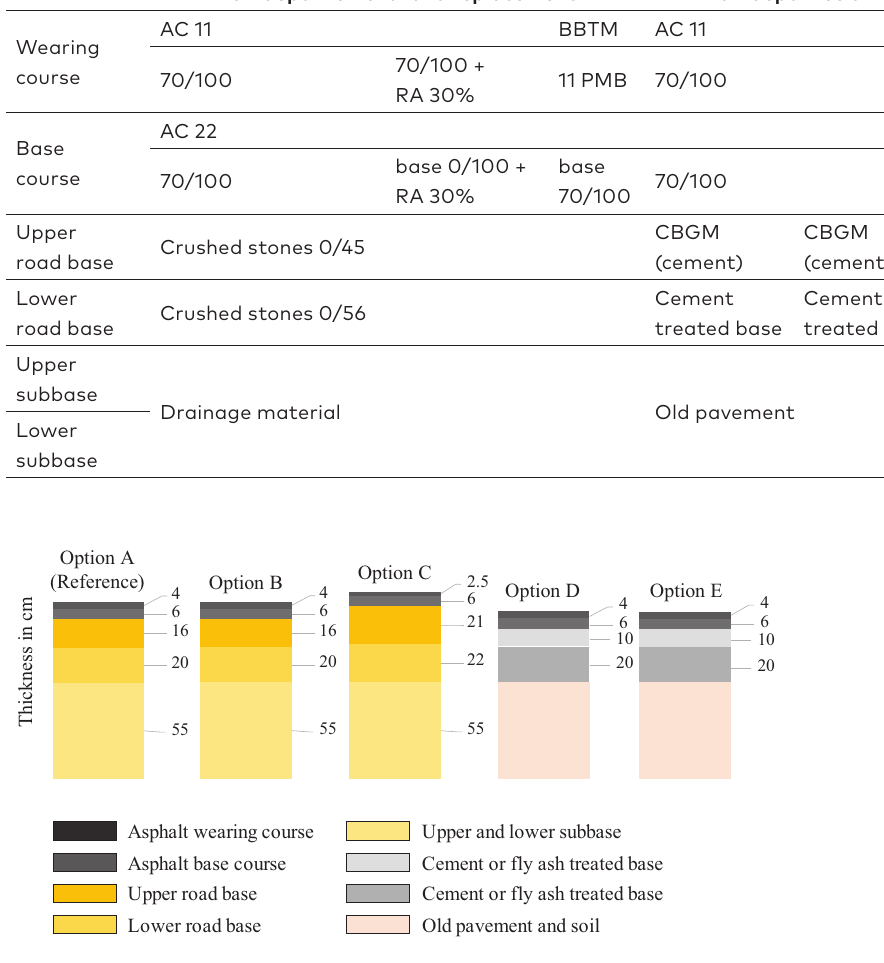
Figure 1. Different initial pavement constructions for the case